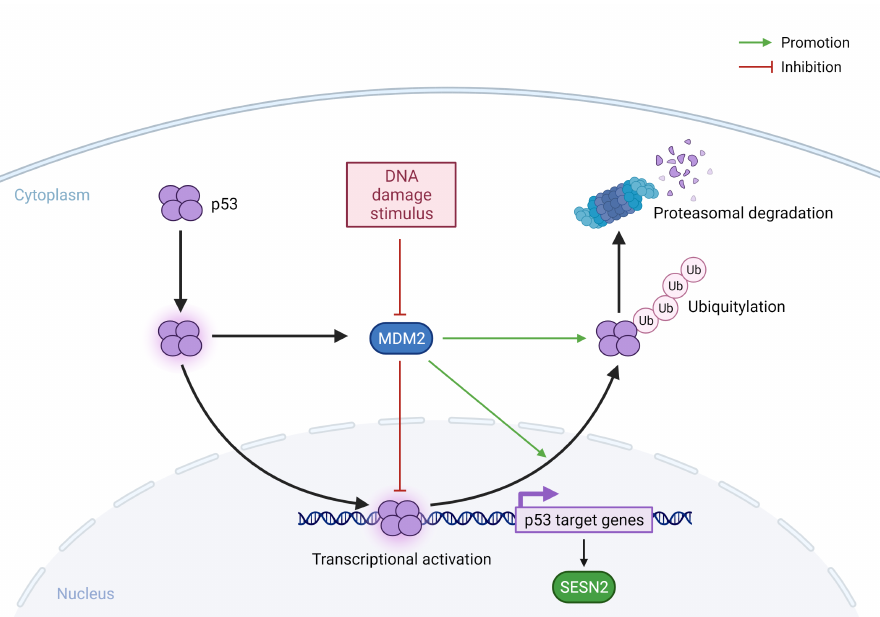
Figure 3. The regulation of SESN2 in response to genotoxic stress. The levels of p53 are kept low via the process of ubiquitination by MDM2 and subsequent proteasomal degradation. Post-translational modifications of MDM2 and p53 in response to genotoxic stress disrupt the interaction between MDM2 and p53, increasing the cytosolic concentration of p53 and its nuclear translocation, and eventually the transactivation of the target genes. MDM2: Mouse Double Minute 2 homolog; Ub: